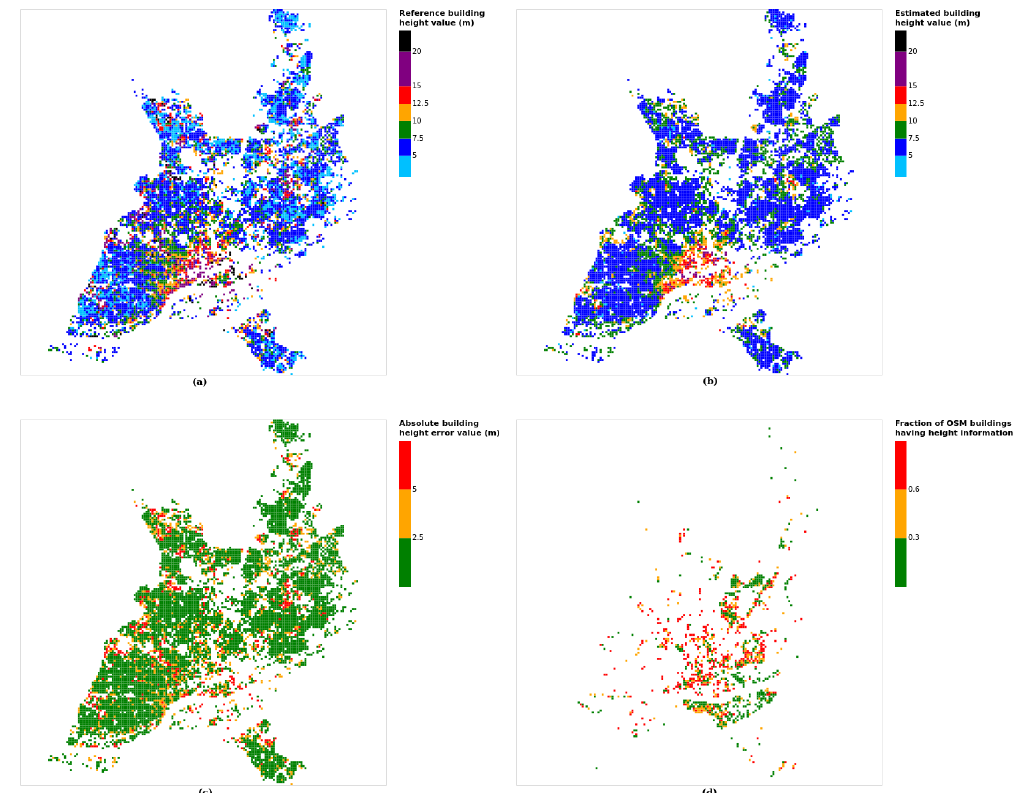
Figure 9. Results for the city of Nantes at grid cell: (a) reference building height, (b) estimated building height, (c) absolute building height error, and (d) fraction of OSM buildings that have height information. For cases (a) , (b) and (c) , only cells that have buildings with at least 90% of their buildings having no height value in OSM are